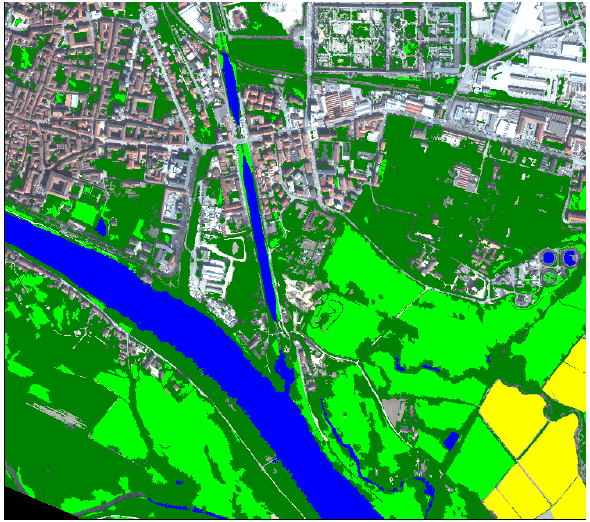
Figure 13. Whole image studied with classified natural elements.